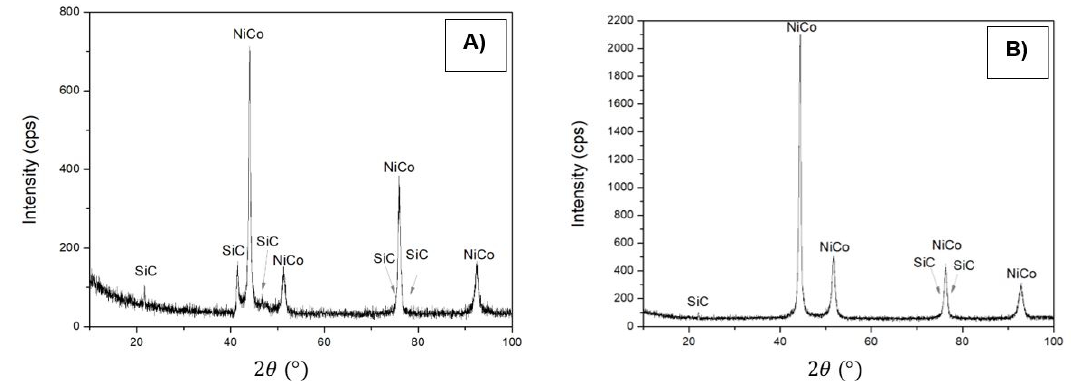
Figure 3. XRD diffractogram of Ni-Co/SiC nancocomposite coating. A) 10 min; B) 20 min. Table 2. Effect of deposition time on grain size and texture coefficient for depositing Ni–Co/SiC nanocomposite. Deposition time